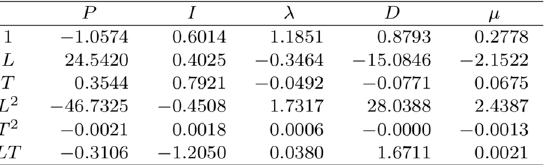
Figure 5. Parameters for the second set of tuning rules for S-shaped response processes ( P = k p , I = k p /T i , D = k p T d ) [32].